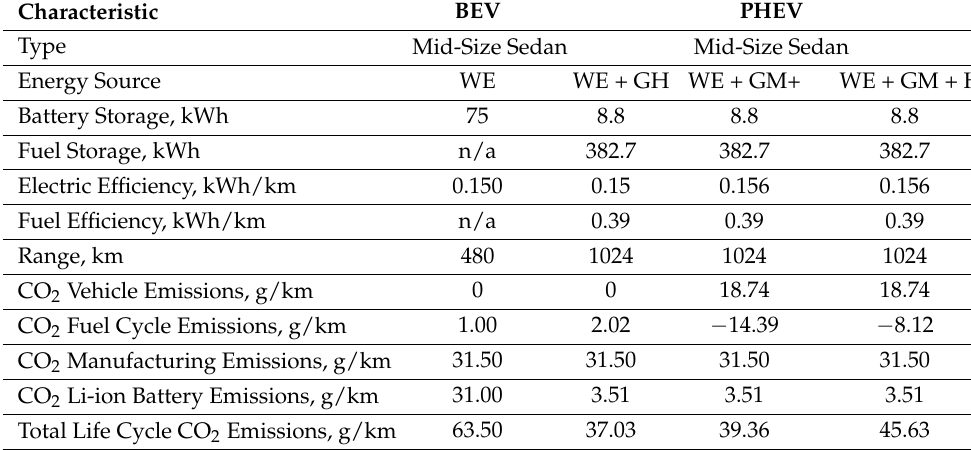
Table 7. Comparison of the life cycle carbon dioxide emissions of the best current technology for PHEVs and for BEVs under the assumption of wind electricity (WE) as well as green hydrogen (WE + GH), green methane with carbon dioxide capture (WE + GM+) and green methane augmented with the conversion of the carbon dioxide and green hydrogen (WE + GM +